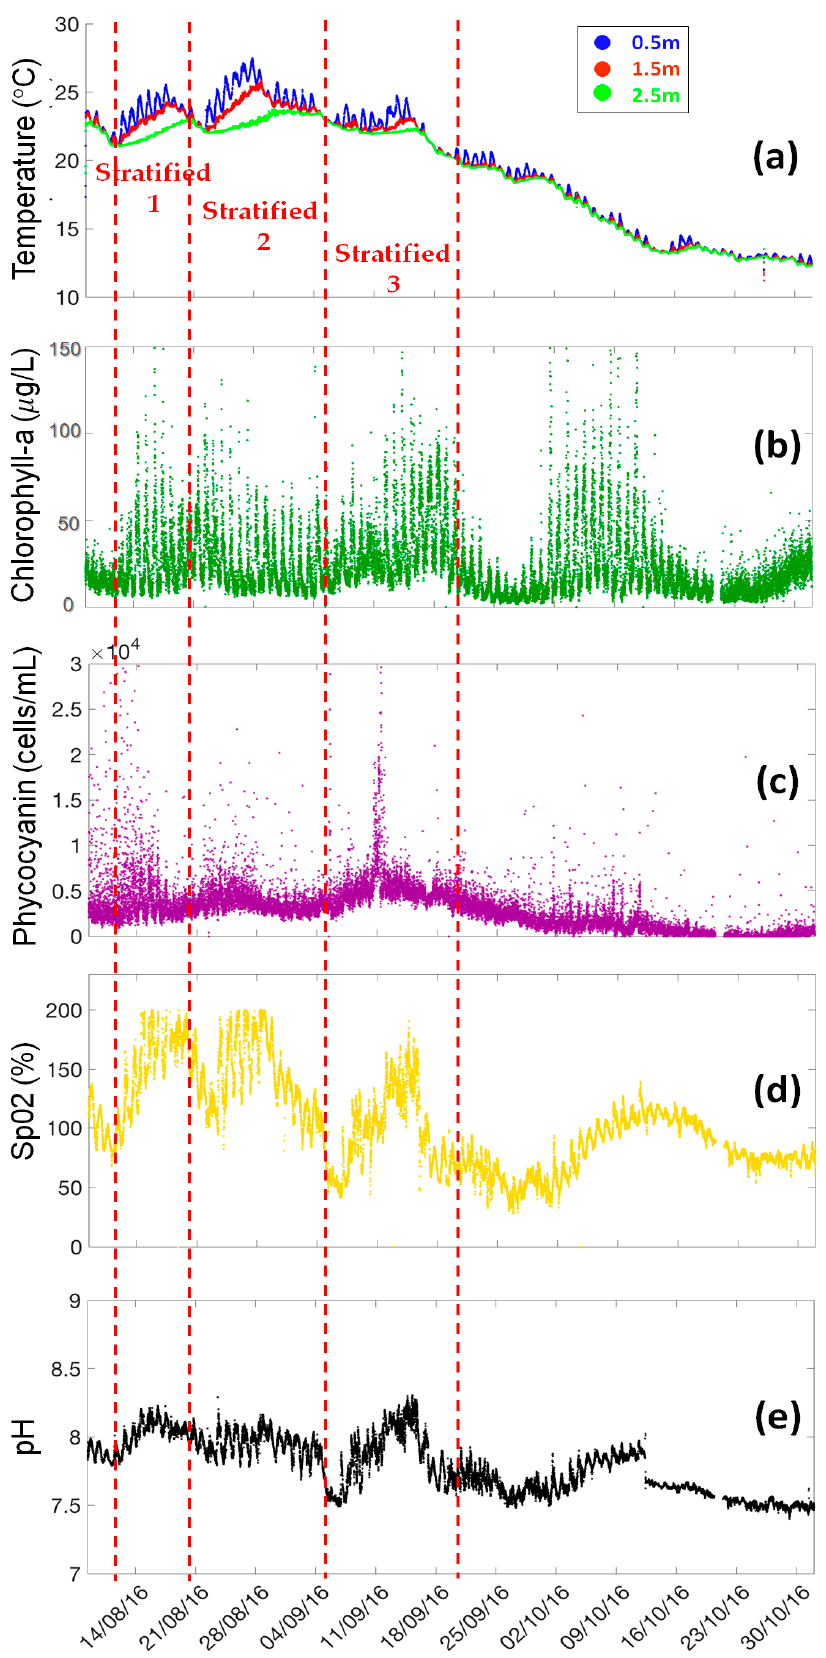
Figure 4. Water temperature ( a ) at 0.5 m, 1.5 m, 2.5 m depths and chlorophyll-a ( b ); phycocyanin ( c ), oxygen saturation ( d ); pH ( e ) at 1.5 m depth at point B from 8 August–31 October 2016.